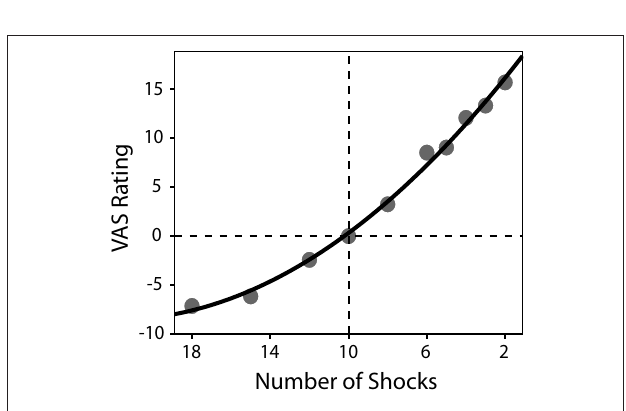
FIguRe 3 | Average normalized VAS ratings as a function of the number of shocks received. A second-order polynomial function was fitted to the data in order to demonstrate the convexity of the observed ratings ( R 2 = 0.995). The reference shocks (10 shocks) are indicated by the lines at the origin. A paired-samples t -test revealed that the slope for less electric shocks ( M = 1.974, SD = 0.644) was significantly greater than the slope for